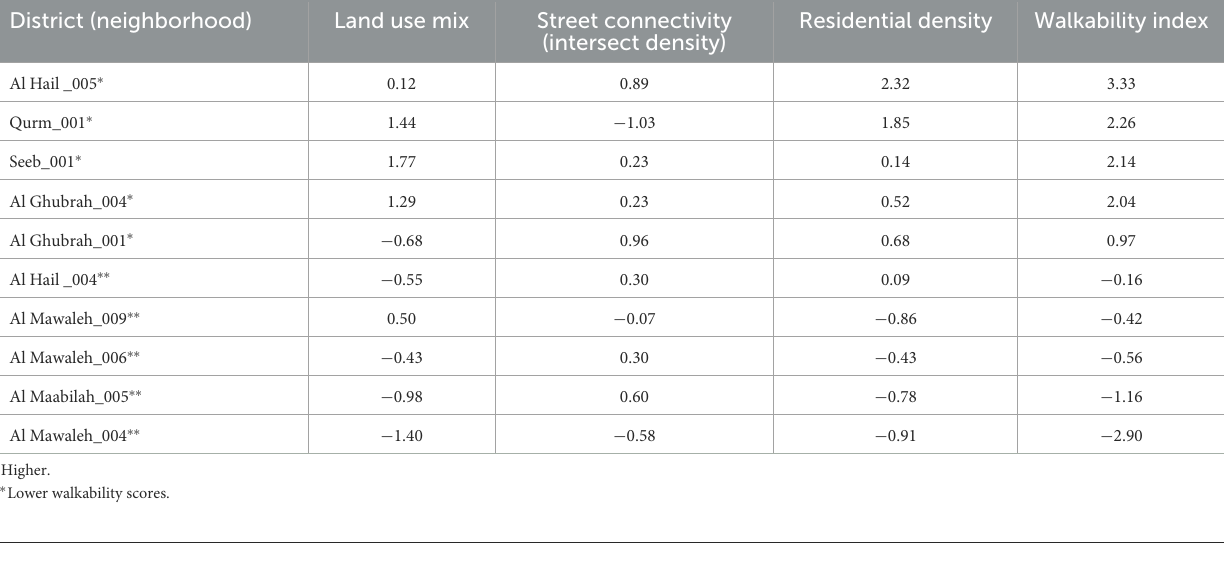
TABLE 1 Walkability scores of the selected study areas.